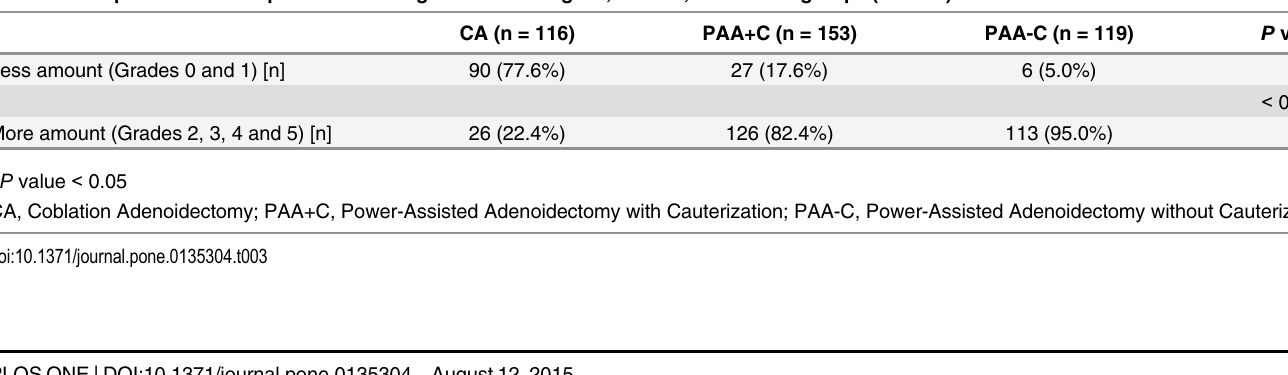
Table 3. Comparison of intraoperative bleeding amount among CA, PAA+C, and PAA-C groups (N = 388).